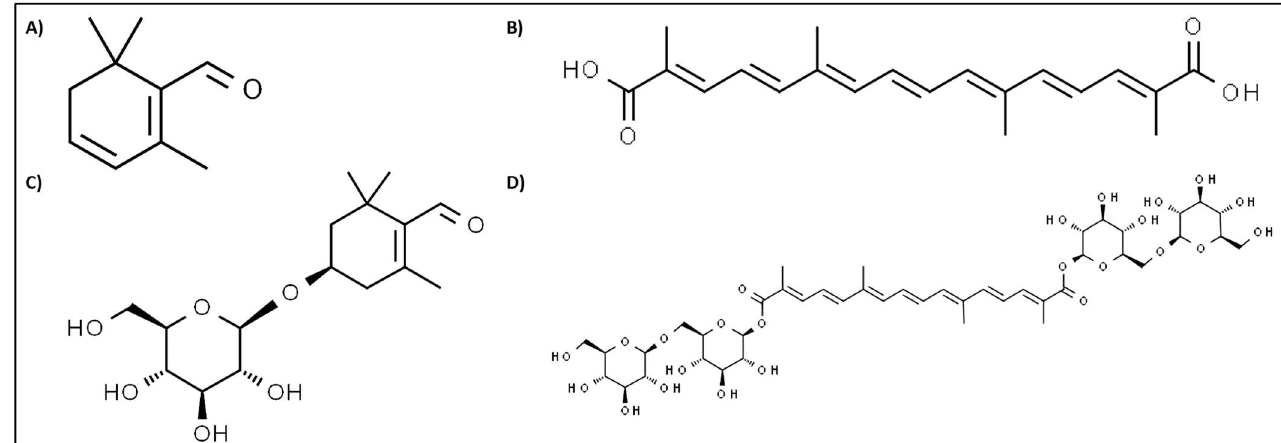
Figure 1. Structural formulas of saffron constituents safranal ( A ) [61], trans-crocetin ( B ) [62], picro- crocin ( C ) [63], and trans-crocetin digentiobiose ester ( D ) [64], one of crocin’s many forms [65].